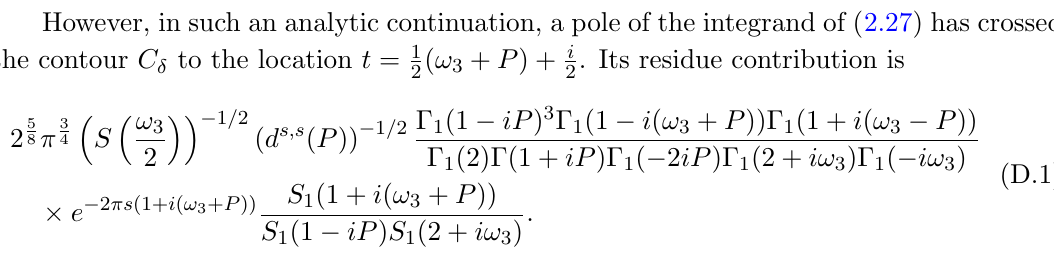
p Re( ! 2 ) (where the regulator is 3